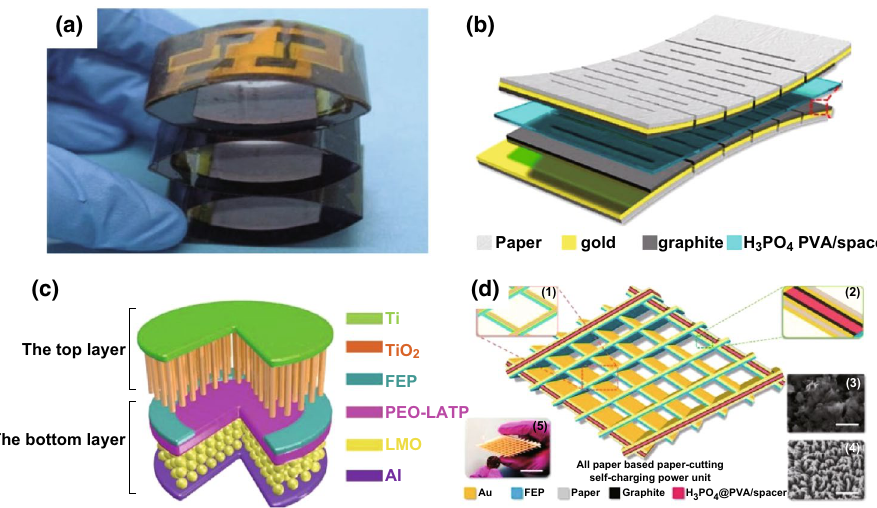
Fig. 6 a Photograph of an as‑fabricated self‑charging power system, including three EP‑TENGs in parallel and three EP‑SCs in series (scale bar, 1 cm). Reprinted with permission from Ref. [24]. b Schematic structure of a kirigami‑based supercapacitor (KP‑SC). Reprinted with permission from Ref. [26]. c Fabrication of the convoluted power device. Reprinted with permission from Ref. [27]. d Structural scheme of the PC‑SCPU. Insets 1 and 2 show the basic working component of the P‑TENG and P‑SC. Insets 3 and 4 are the SEM image of the graphite‑based electrode (scale bar, 2 μm) for the P‑SC and the nanostructured FEP film (scale bar, 2 μm) for the P‑TENG. Inset 5 shows a photograph of the as‑prepared P‑SCPU, which is compared with a coin (scale bar, 3 cm). Reprinted with permission from Ref.